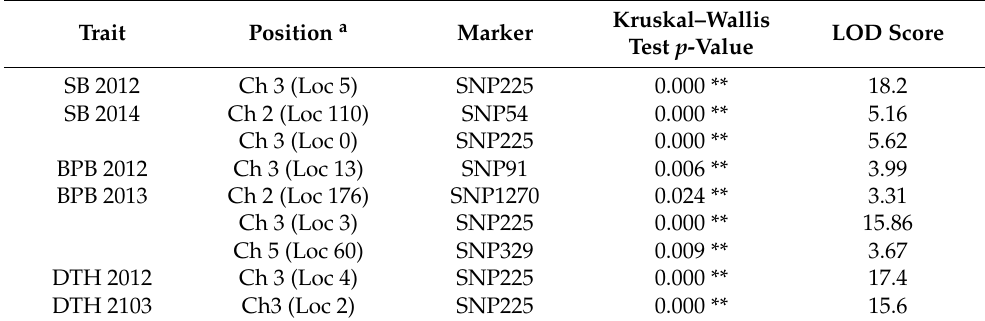
Table 4. Markers associated with bacterial panicle blight (BPB), sheath blight (SB), and days to 50% heading